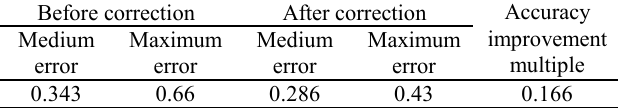
Table 2 Surface Fitting Method Accuracy Comparison before